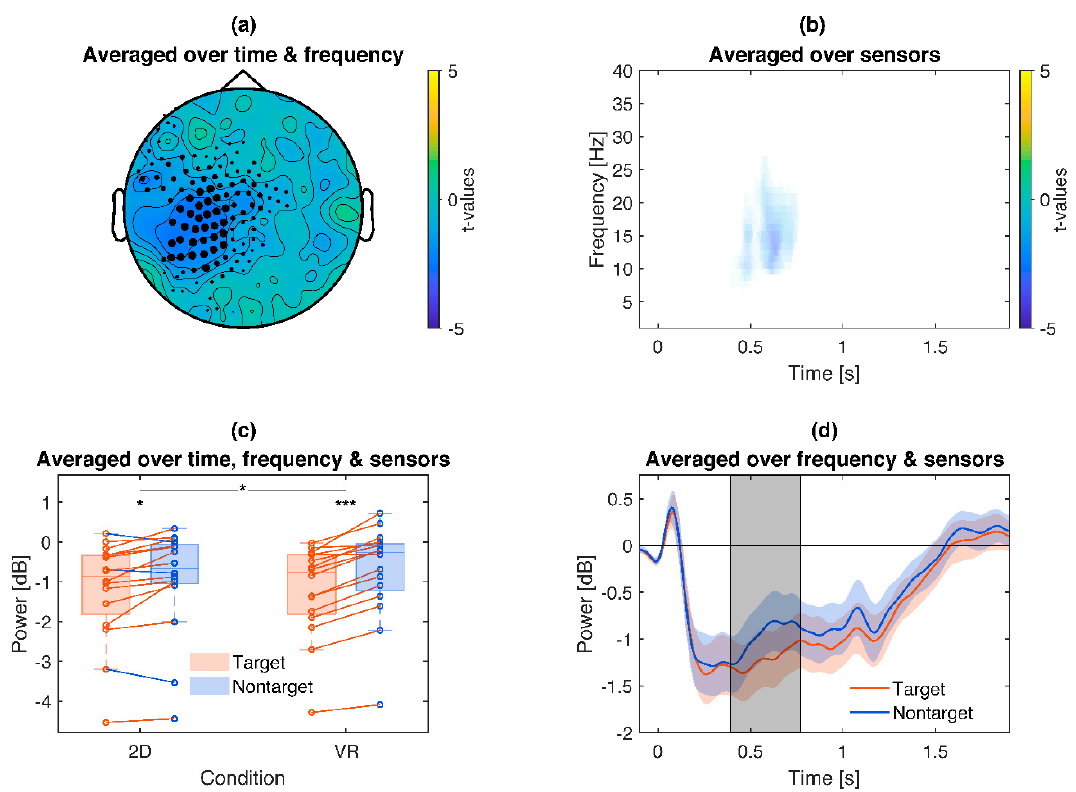
Figure 5. Illustration of the target frequency effects: Target pictures lead to a stronger alpha event related desynchronization (ERD), which is even stronger in VR. ( a ): Topography of t-values averaged across the significant time points and frequency bins. ( b ): Time-frequency plot of t-values, averaged across sensors of the respective cluster. Only time-frequency bins which are part of the cluster are displayed. ( c ): Box plot and single subject values from the cluster. Red lines indicate a stronger ERD for target compared to nontarget pictures, blue the opposite. Asterisks indicate the significance of exploratory post-hoc group comparisons: *** p < 0.001, * p < 0.05. ( d ): Time course of the cluster. Colored shaded areas signify standard errors. Grey shaded areas signify the latency of the cluster.